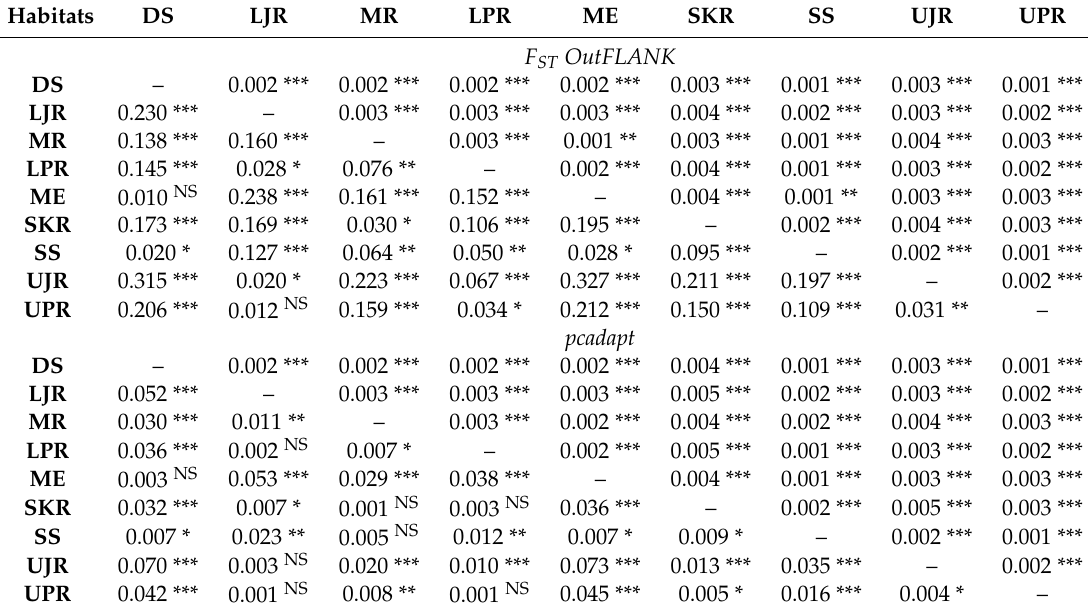
Table 2. Pairwise F ST values for the putatively neutral (above diagonal) and putatively adaptive (below diagonal) panel of SNP loci of T. ilisha collected from the nine strategic collection sites, identified by the F ST OutFLANK and pcadapt